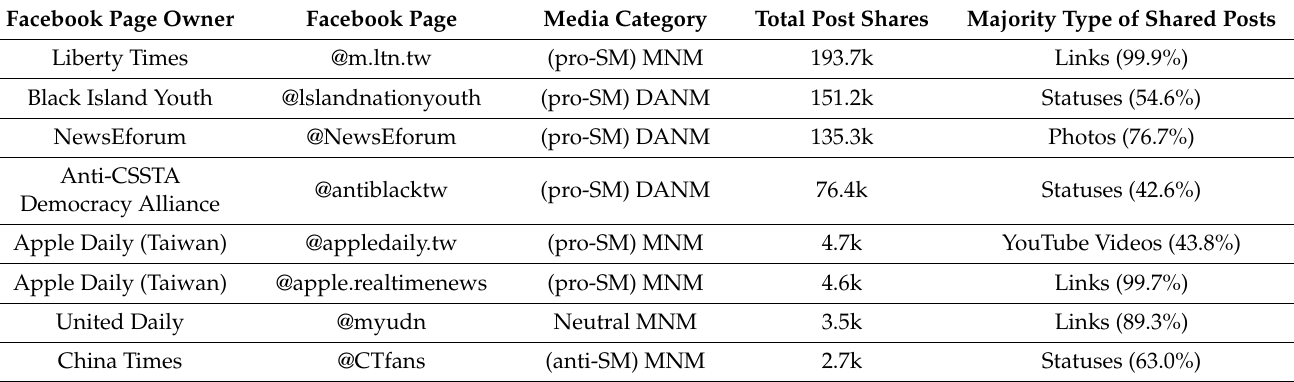
Table 1. Share counts of Facebook posts during the SM (18 March and 10 April 2014)